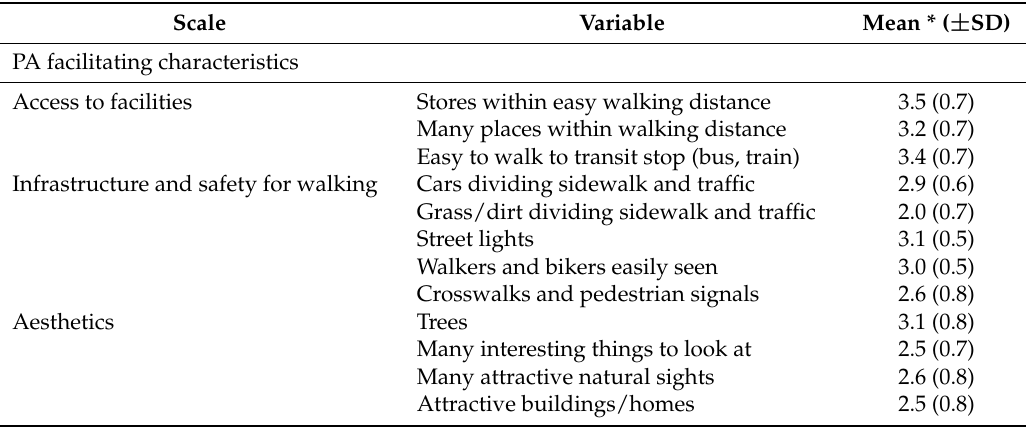
Table 3. Mean scores ( ± SD) per item of NEWS